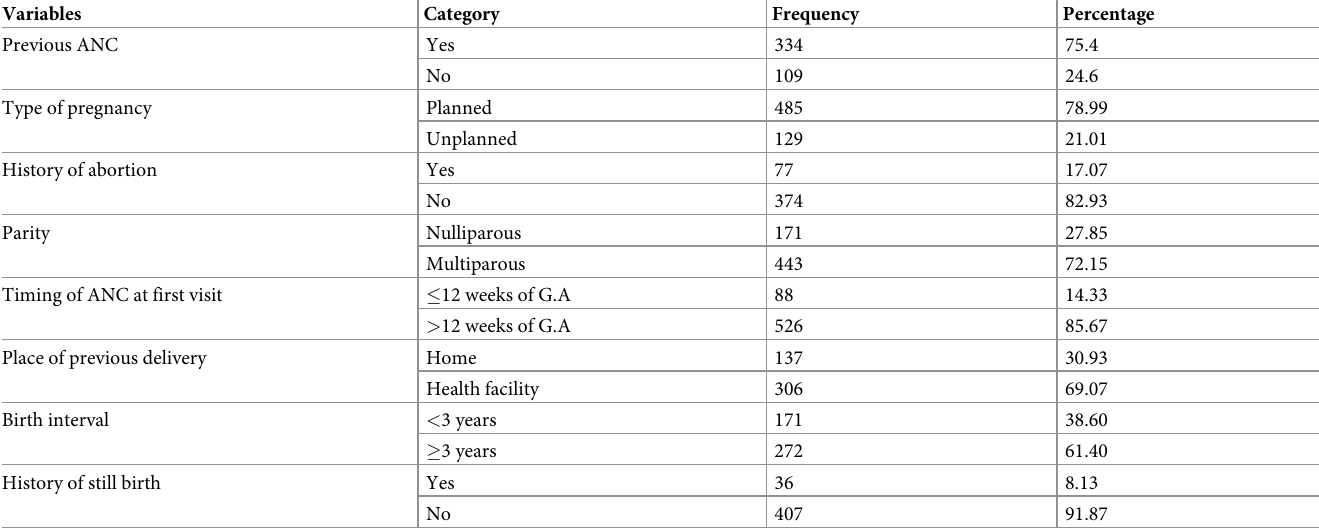
Table 2. Obstetric history of pregnant women attending ANC in central zone of Tigray Region, Ethiopia in November 1/2017 to January 30/2018. Variables